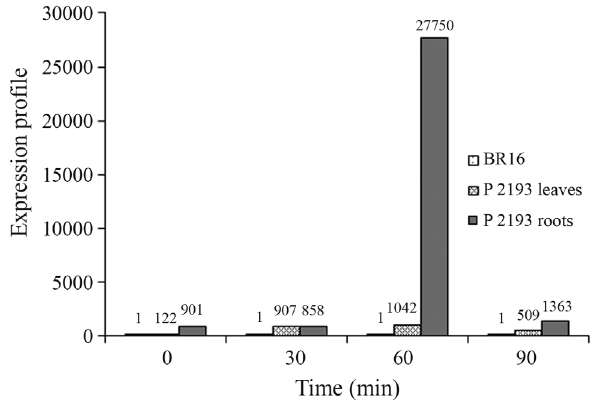
Figure 5 - Relative gene expression of the AtDREB2A CA transgene in leaves and roots of the T 2 generation of P2193 during stress induced by a water deficit. Transgene expression was normalized to the reference genes GmrRNA18S and Gm (cid:5) _actin and then calibrated with the corresponding time points and tissue from control plants (cultivar BR 16) (p < 0.001). Statistical analyses were done using RESTmsc software and all treatments of leaves and roots were significantly higher than the Table 3 - Relative gene expression of the AtDREB2A transgene in the leaves and roots of T 2 generation, GM plants P2193, grown under hydroponic con- ditions. Organ